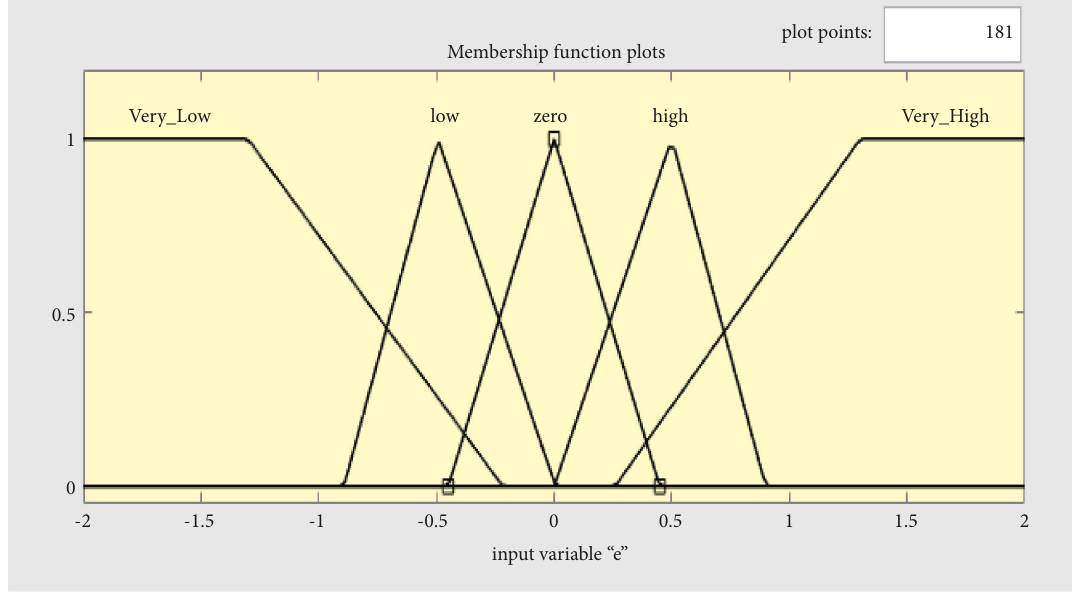
Figure 23: The 1 st input (e) Membership